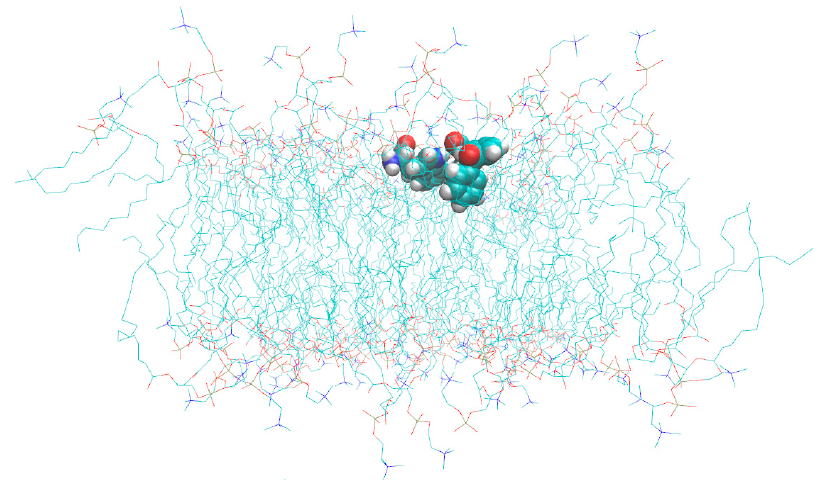
Figure 11. Snapshot of MD trajectory with deprotonated KP-D-Trp associate. Water molecules are not